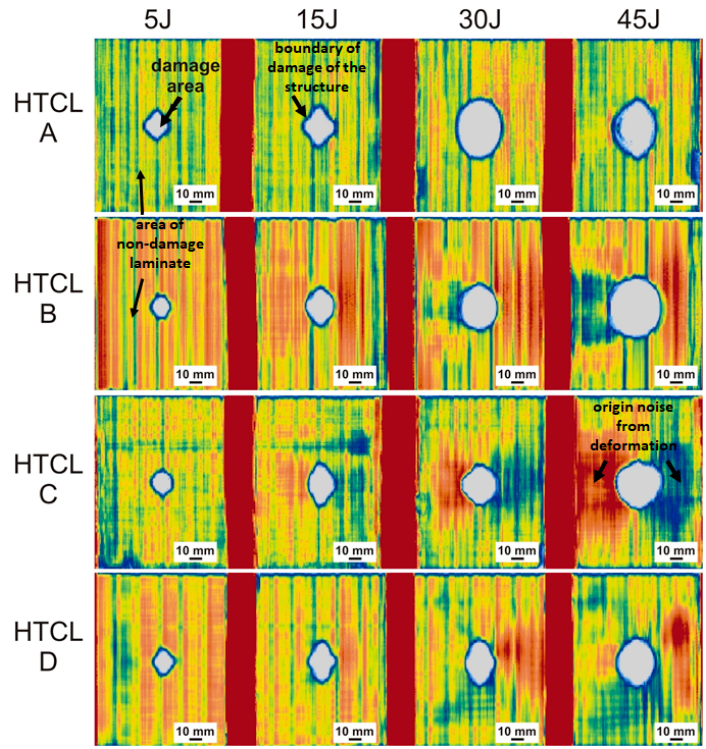
Figure 8. C-scan maps of damage of HTCL with various metal volume fractions after impact.